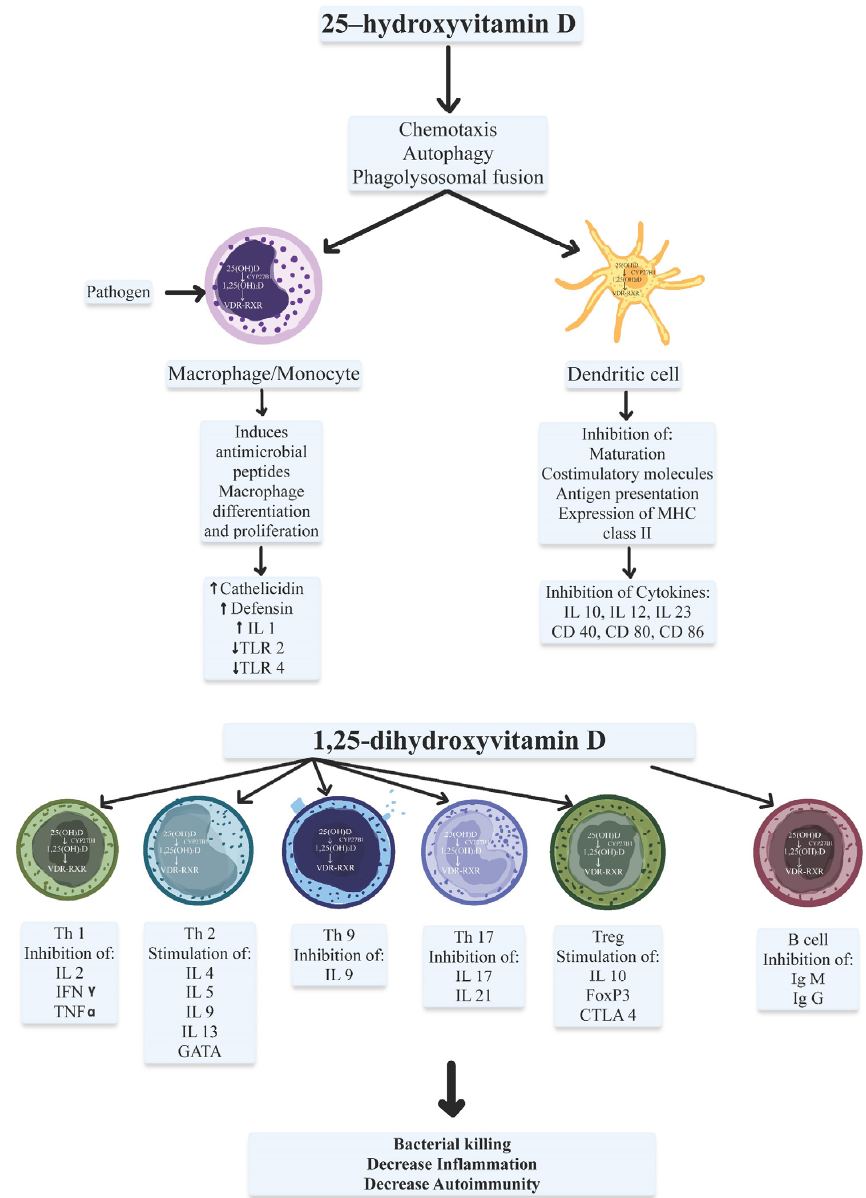
Figure 1. Immunomodulatory actions of active vitamin D (1,25-dihydroxyvitamin D3; 1,25-(OH)2D3) include effects on the innate and adaptative immune systems. 1,25-(OH)2D3 exerts its effect via direct binding on both VDR on the dendritic cell (DC) and the T lymphocytes. Calcitriol intervenes in APC differentiation and function by promoting APC to become more tolerogenic and decreasing the expression of major histocompatibility complex (MHC) class II and other similar molecules on the cell surface. Vitamin D may also reduce T helper (Th) cell differentiation and proliferation and induce a more tolerogenic immune response than a pro-inflammatory status with induction of T helper-2 (Th 2)-lymphocytes and regulatory T lymphocytes (Tregs), with downregulation of the pro-inflammatory T helper-1 (Th 1) lymphocytes, T helper-17 (Th 17) lymphocytes, and T helper-9 (Th 9) lymphocytes. Other abbreviations: IL: interleukin; Ig M: immunoglobulin M; Ig G: immunoglobulin G; IFN- γ : interferon- γ ; TNF- α : tumor necrosis factor- α ; toll-like receptors (TLRs), GATA-3: GATA binding protein-3; FoxP3: forkhead box P3, CTLA-4: cytotoxic T lymphocyte-associated